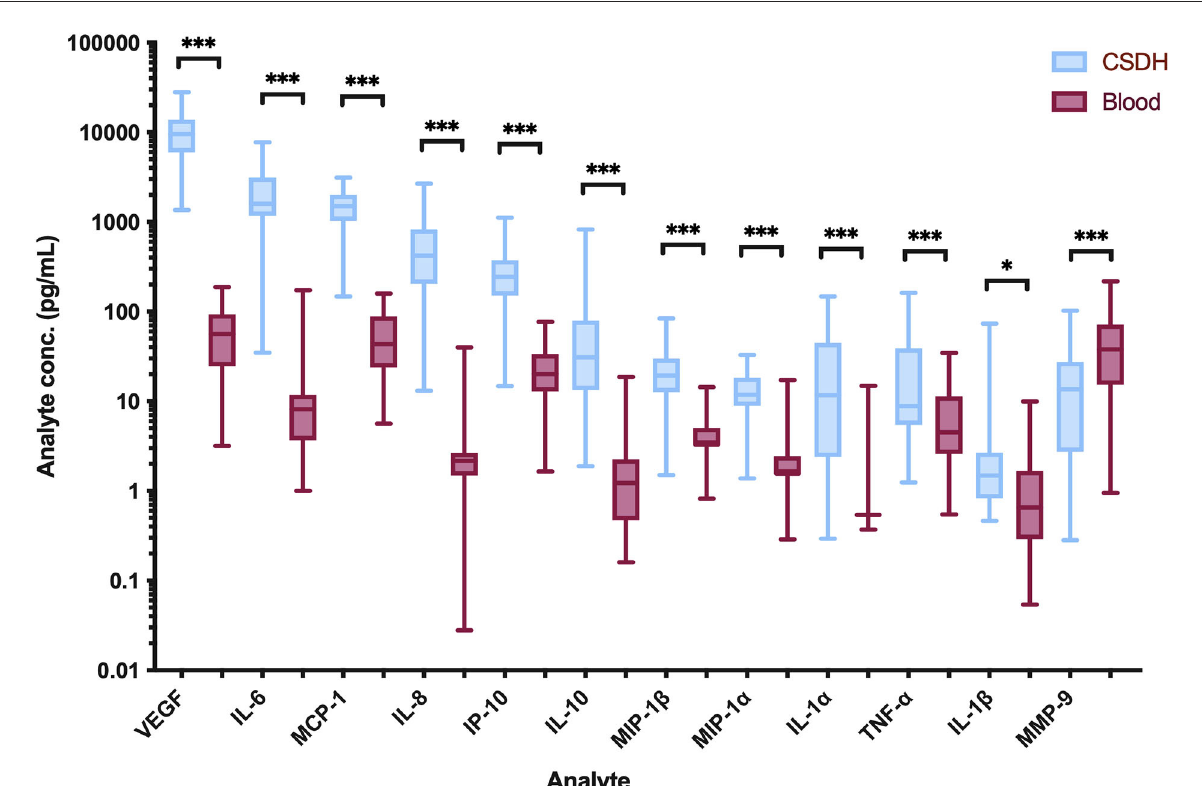
FIGURE1 Intraoperative inflammatory marker concentrations detected in CSDH fluid (blue) and blood plasma (red). All values are the mean of two replicates, n = 67 from 51 patients. Line (median), box (interquartile range), and whiskers (minimum-maximum). Statistically significant differences are shown as * p < 0.05 and *** p < 0.0001.